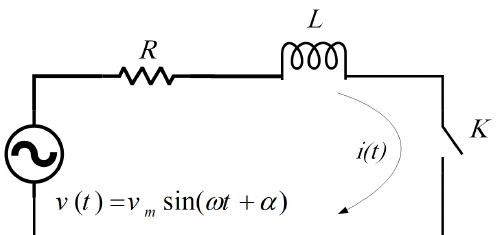
Figure 1. An equivalent circuit for fault analysis: switch K is closed for fault simulation.